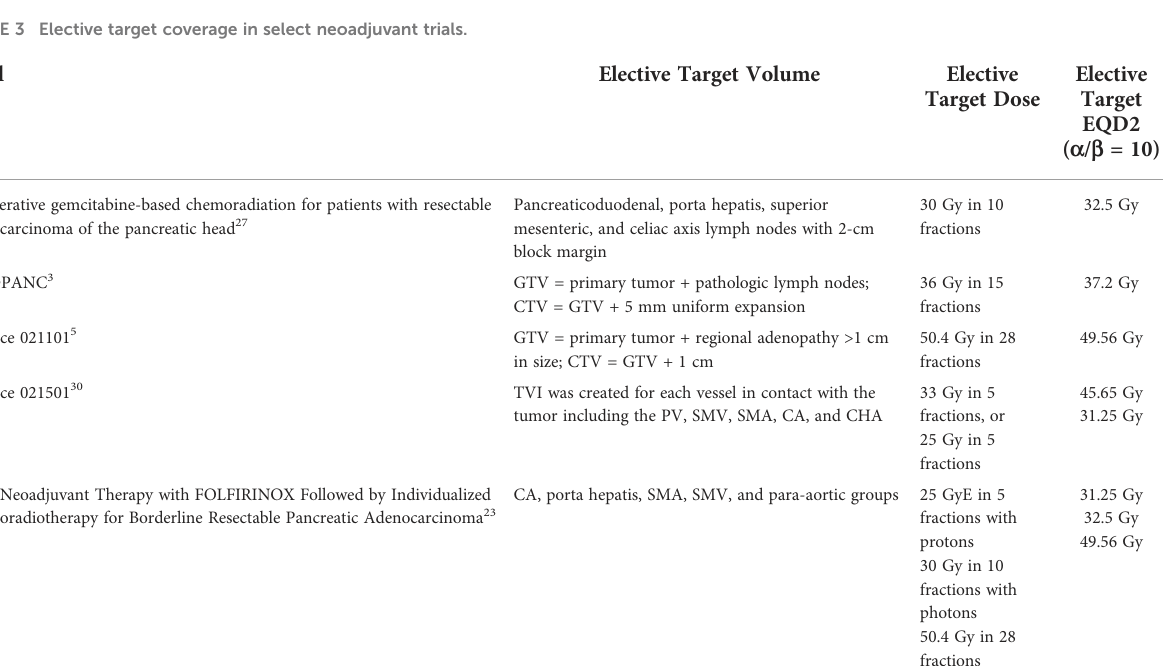
2-Gy fractions, 45 Gy in 1.8-Gy fractions, 36 Gy in 2.4-Gy fractions, and 33 Gy in 6.6-Gy fractions.